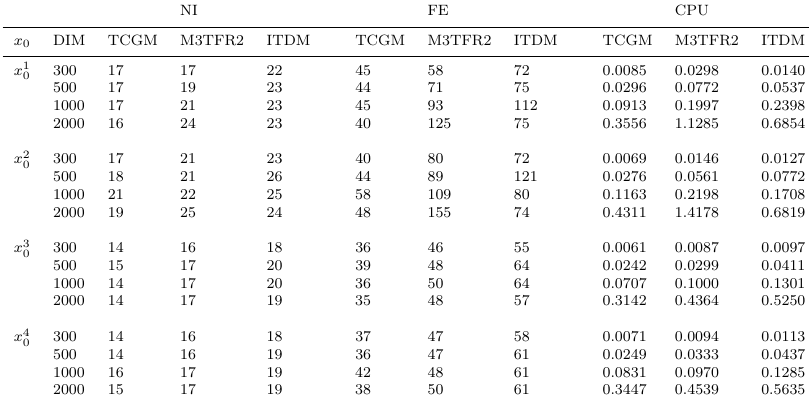
Table 2. Numerical results of Problem 2.